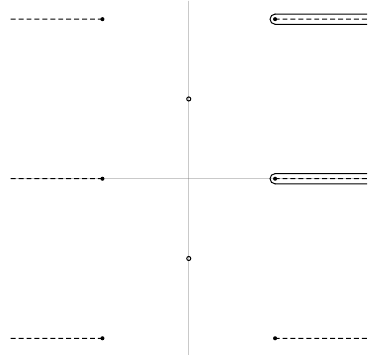
Figure 5. Reflected saddles with constant imaginary part. For η real and less than w , there is a real saddle corresponding to a particle that comes in from r → ∞ , rolls partway up the hill until it stops at the turning point, and then rolls back out to infinity. The corresponding contour in the complex r -plane is pictured here, slightly deformed away from being pure real so that the incoming and outgoing segments of the contour do not overlap. Due to the r → r + πi shift symmetry of the complexified problem, one likewise has shifted contours with constant imaginary part πN 1 , such as the second contour in the figure with N 1 = 1 . The dashed lines represent branch cuts of the square-root in eq.